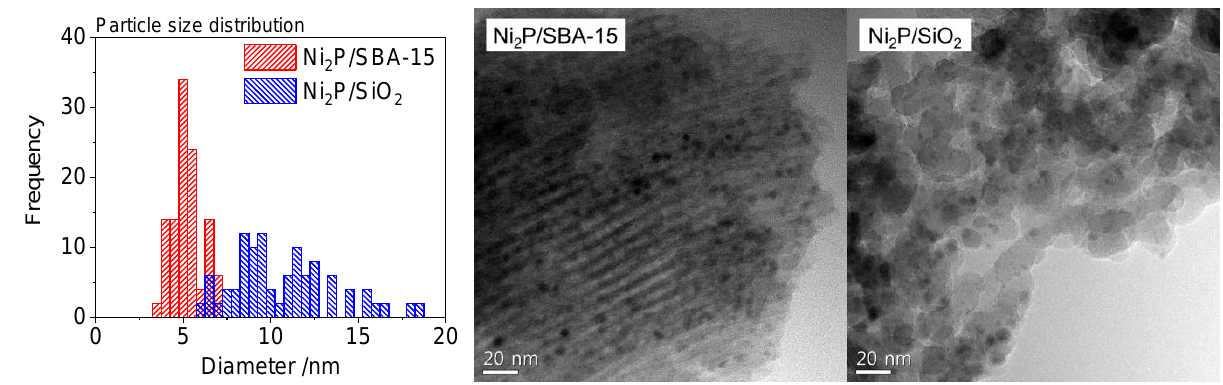
Figure 2. TEM images and particle size distributions of Ni 2 P/SBA-15 and Ni 2 P/SiO 2 .